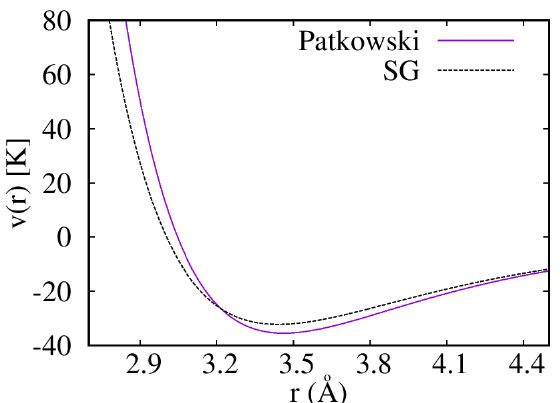
Figure 1. Comparison of Patkowski [40] and Silvera-Goldman [27] (dashed line) intermolecular pair potential for p -H 2